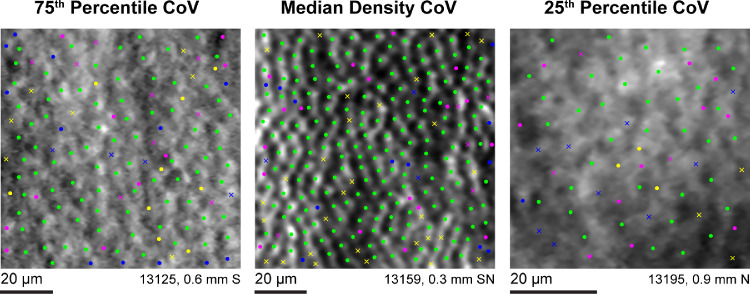
Intergrader reliability for manual cone selections. Green dots represent locations where all three graders identified a cone. Colored dots represent locations where an individual grader identified a cone. Colored x's represent locations where two of the three graders identified a cone, with the color corresponding to the grader who did not identify a cone at that location. Yellow = grader 1A, blue = grader 2, and magenta = grader 3. The three images shown represent the median, 25th, and 27th percentiles for the coefficient of variation (CoV) of cone density calculated from each of the three graders cone identifications. S = superior, N = nasal.